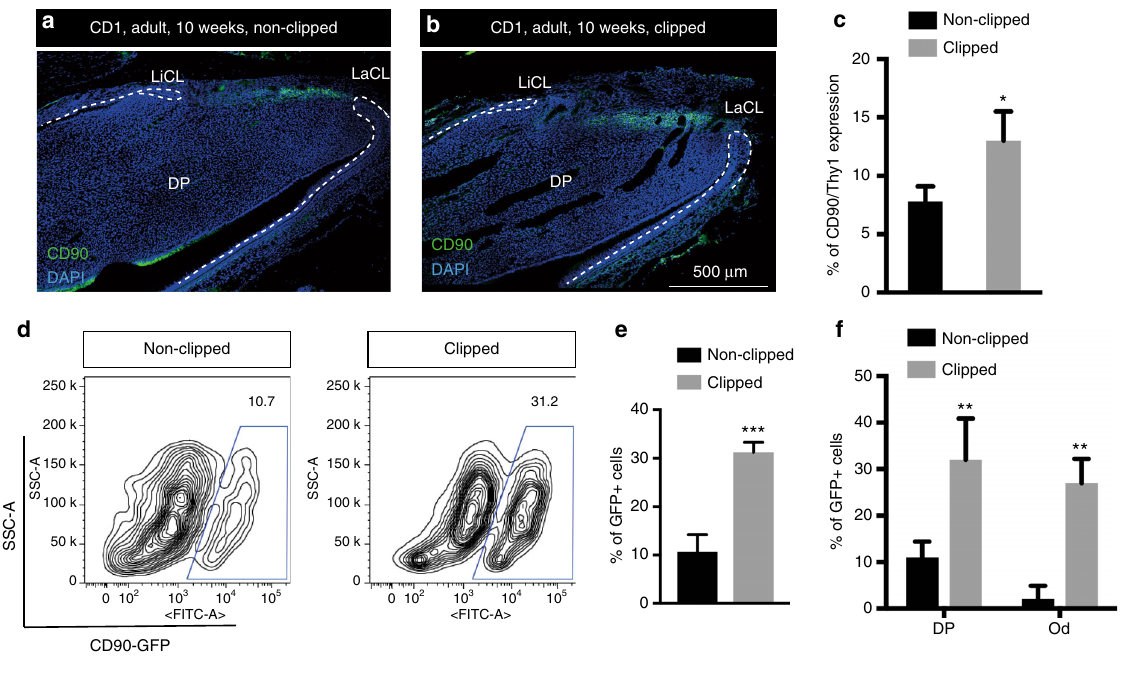
Fig. 5 Increased CD90/Thy1 expression is localized to the incisor MSC region after clipping. a , b Immuno fl uorescent staining of CD90/Thy1 identi fi es expression localized to the region in dental pulp between the epithelial cervical loop and no expression is detected in the TAC region 2 days after clipping. c Quanti fi cation of CD90/Thy1 expression in clipped incisors compared to unclipped incisors ( N >= 3 per group, 10 week adult mice). d , e FACS analysis of CD90/Thy1 cre; mTmG mice shows a three fold increase in GFP + cells from clipped incisors compared to unclipped. f Quanti fi cation of GFP + cells in the pulp cells and odontoblasts on sagittal sections. N >= 5 mice per group. * P < 0.05, ** P < 0.01 and *** P < 0.001 by Student ’ s t -test. Data presented as mean ±